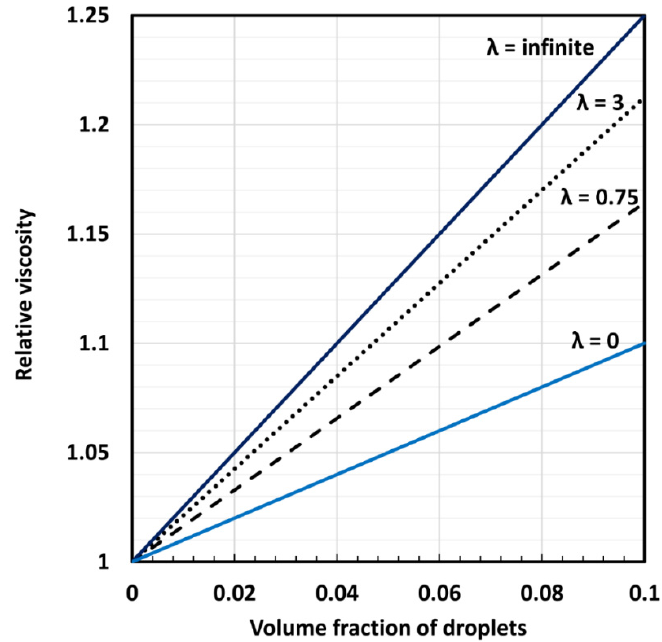
Figure 18. Relative viscosity η r versus droplet concentration φ for dilute emulsions for di ff erent values of the viscosity ratio λ .